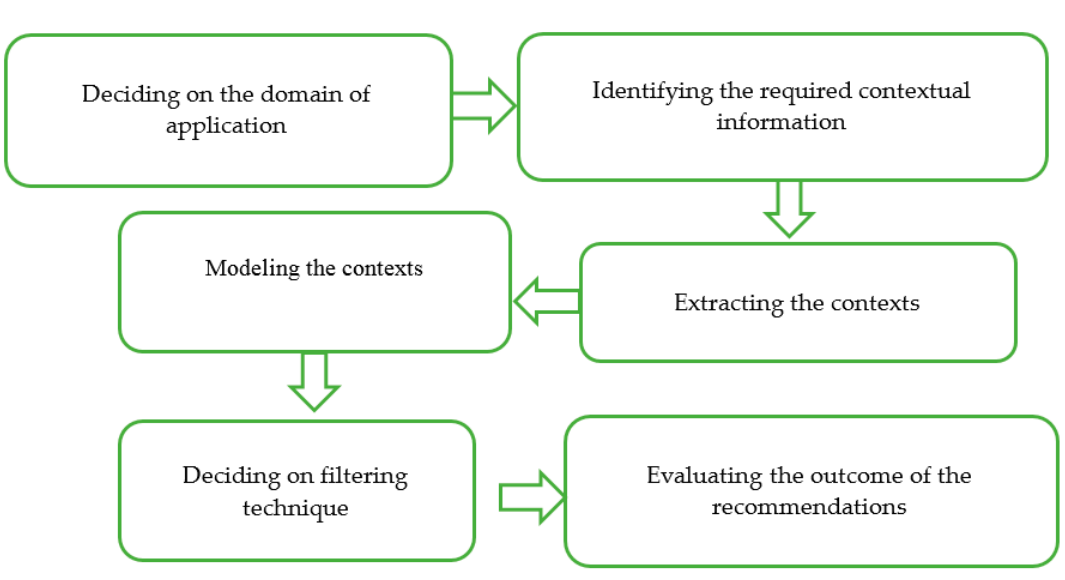
Figure 8. Developmental stages in Context-Aware Recommender Systems (CARS).